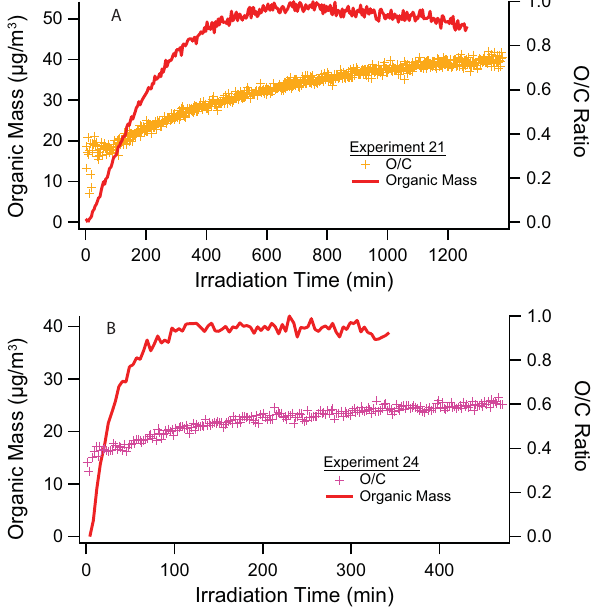
Fig.13. Organicmassand O/Cratioasafunctionoftimefortypical Fig. 13. Organic mass and O/C ratio as a function of time for typical naphthalene photooxidation experiments under low- NO x (Experi- naphthalene photooxidation experiments under low-NO x (Experi- ment 21, A ) and high- NO x (Experiment 24, B ) conditions. Mass loadings are calculated by multiplying the change in DMA volume ment 21, A ) and high-NO x (Experiment 24, B ) conditions. Mass by an estimated density (Chan et al., 2009a). loadings are calculated by multiplying the change in DMA volume by an estimated density (Chan et al., 2009a).